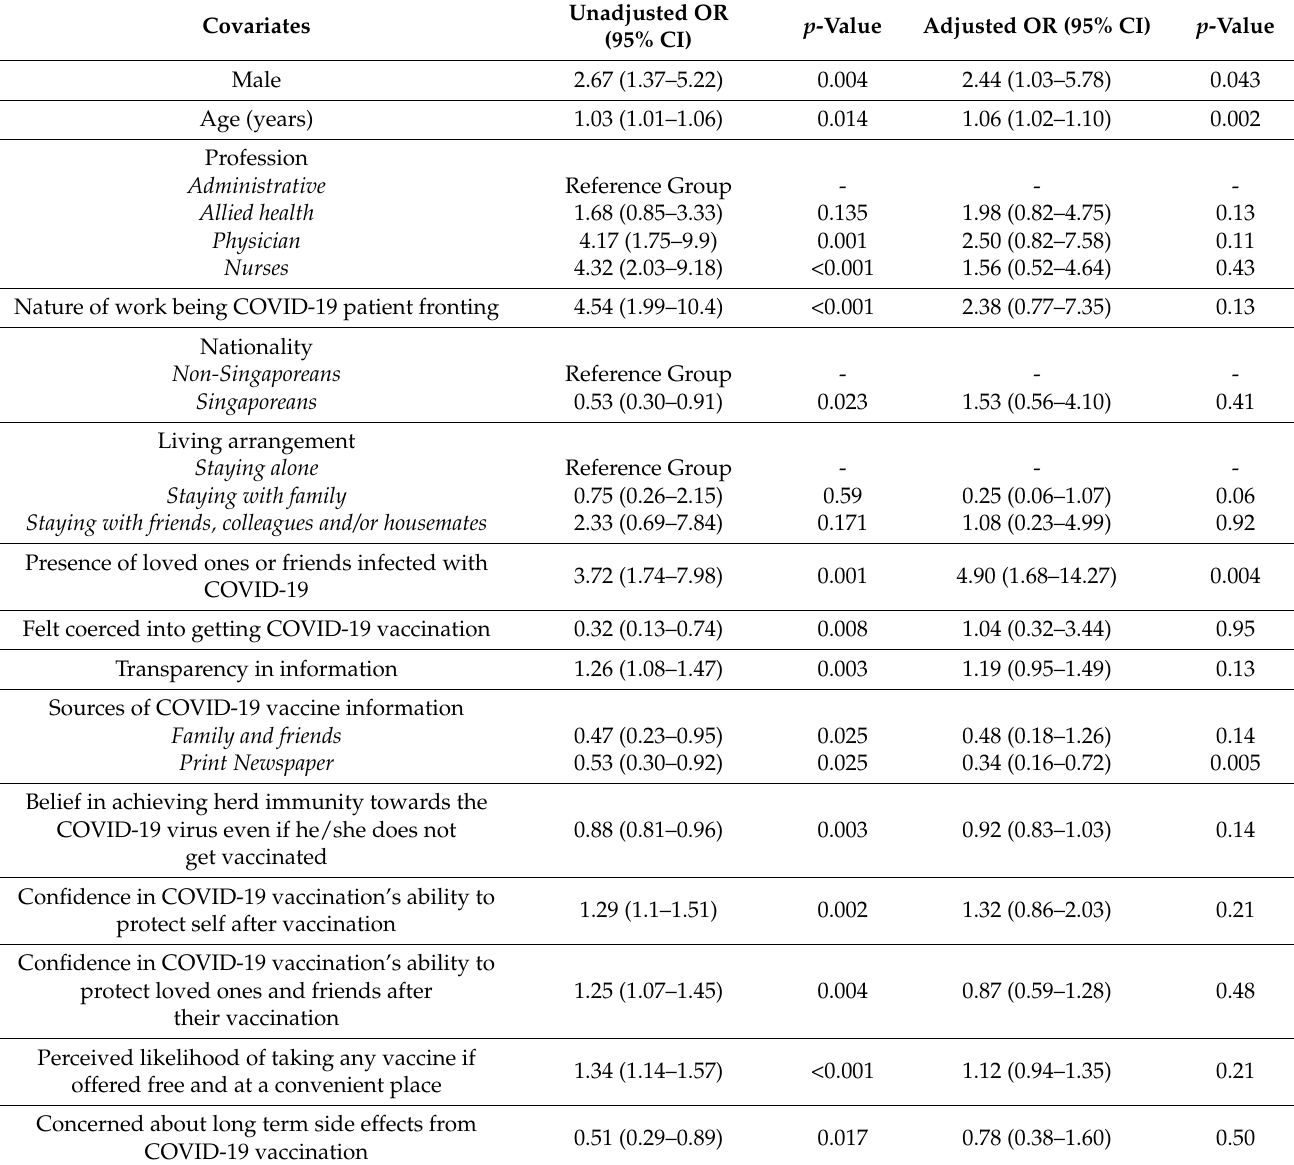
Table 3. Odds ratios of covariates on COVID-19 vaccination